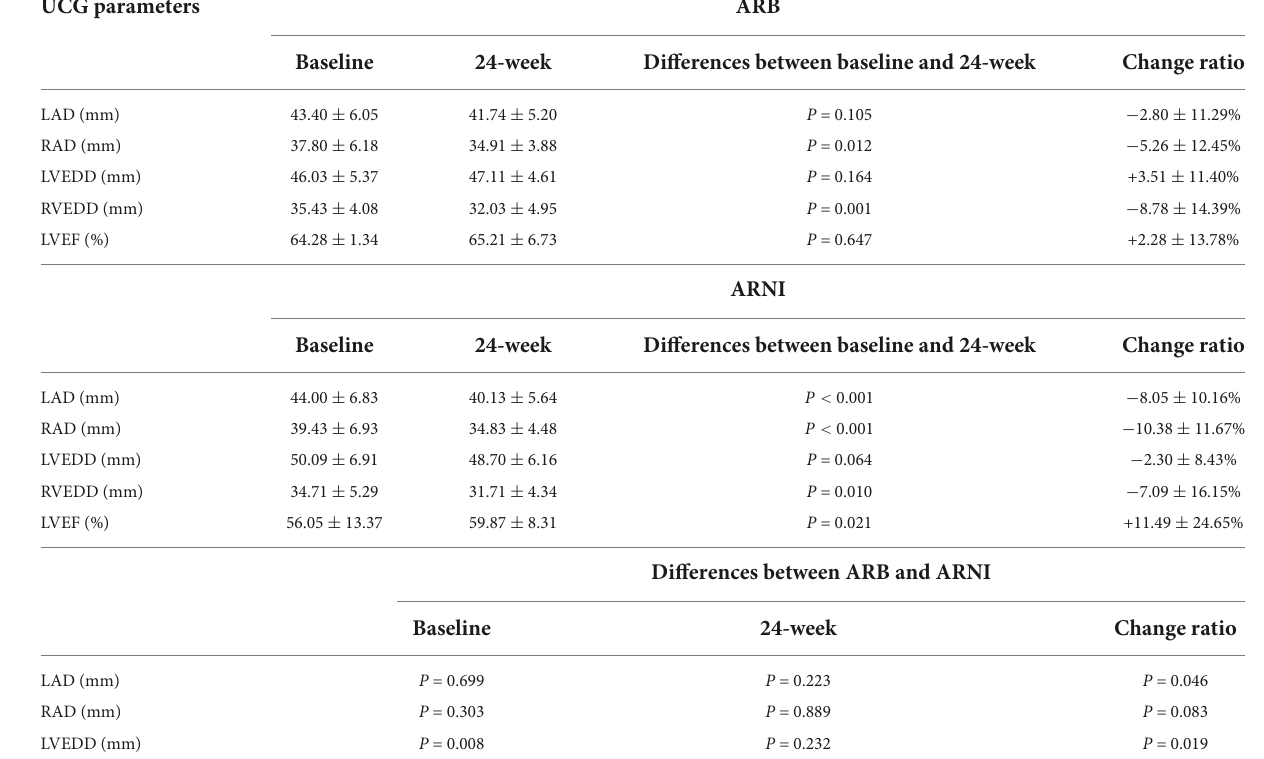
TABLE 2 Ultrasound cardiogram parameters at baseline and 24-week follow-up.